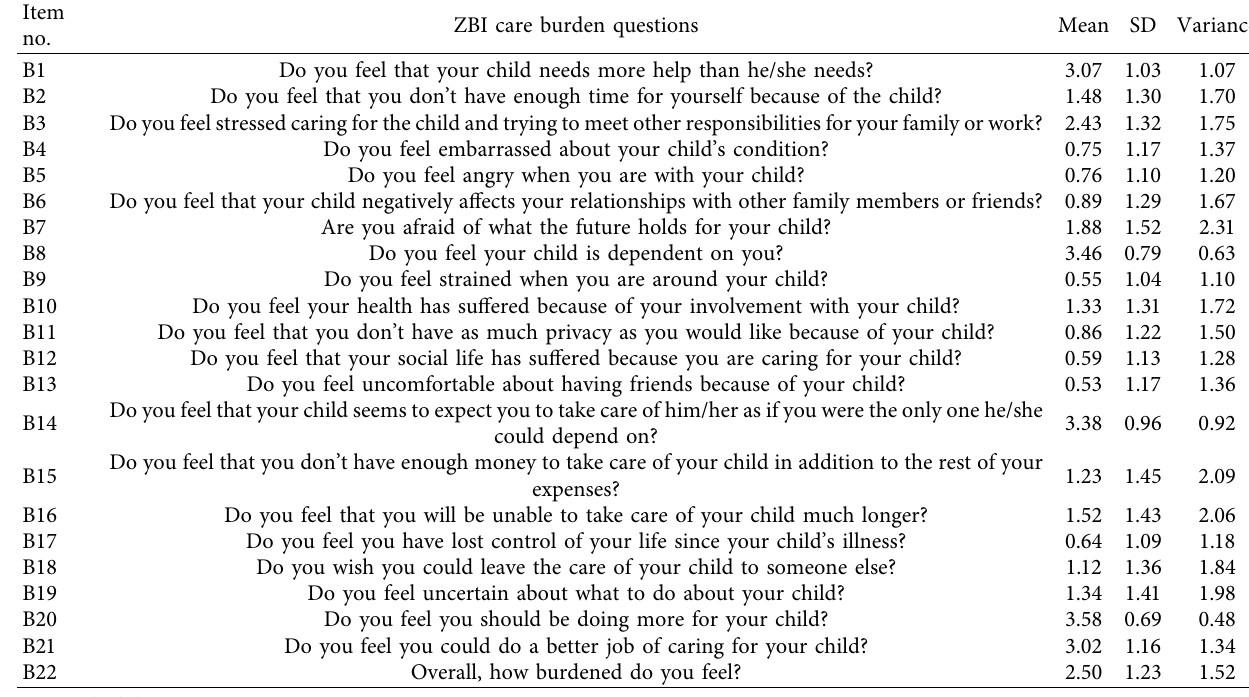
Table 2: Mean scores of caregivers’ responses to care burden assessment questions ( n � 113).